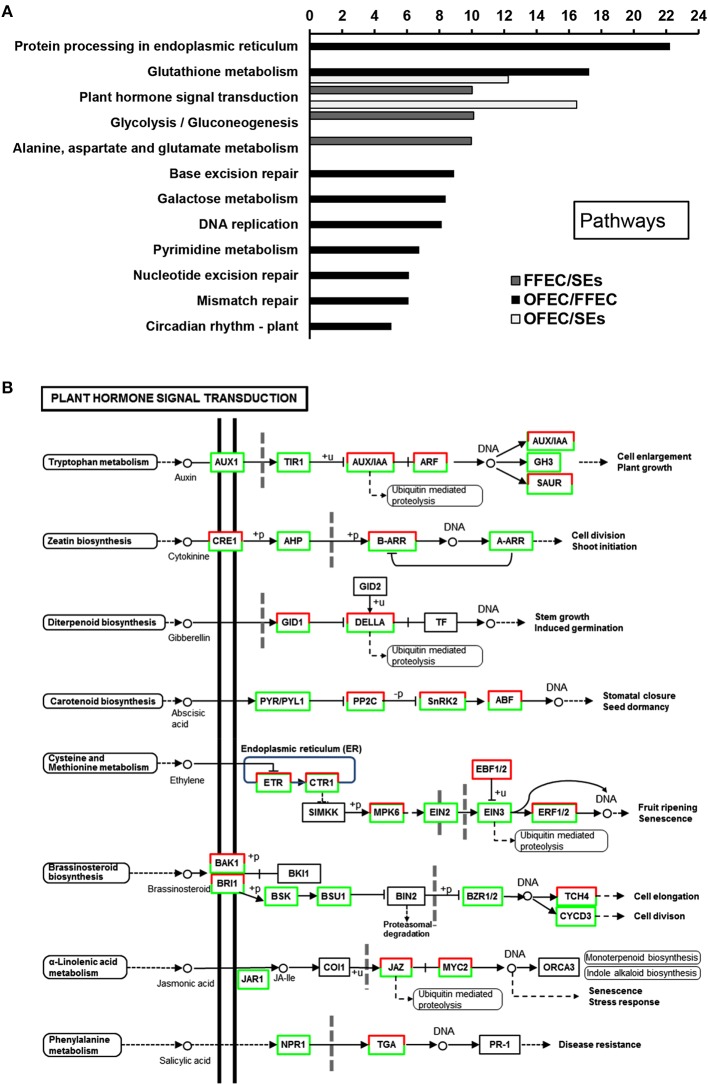
Significantly enriched pathways (A) and changes of plant hormone signal transduction (B) by comparing SEs, FFEC, and OFEC (P < 0.05). The “y” axis represented enriched pathways among the three samples, and the “x” axis represented the P-value (−log2
P).